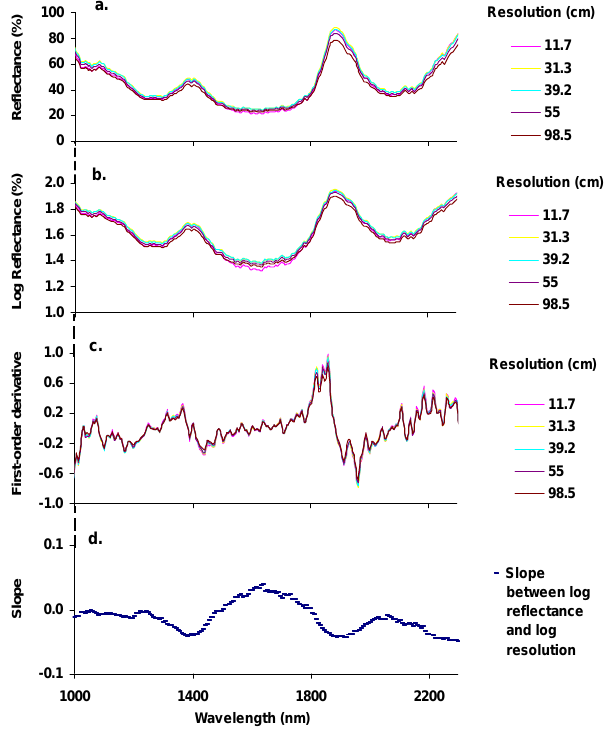
Fig. 4 – Data obtained in July August 12, in site 106, using the wavelength range of 1000- Fig. 4. Data obtained in 12 August 2007, in site 106, using the 2300 nm, at various spatial resolutions; a. Reflectance. b. Log reflectance. c. First-order wavelength range of 1000–2300nm, at various spatial resolutions; derivative. d. slope between log reflectance and log resolution. (a) Reflectance. (b) Log reflectance. (c) First-order derivative. (d) slope between log reflectance and log resolution.